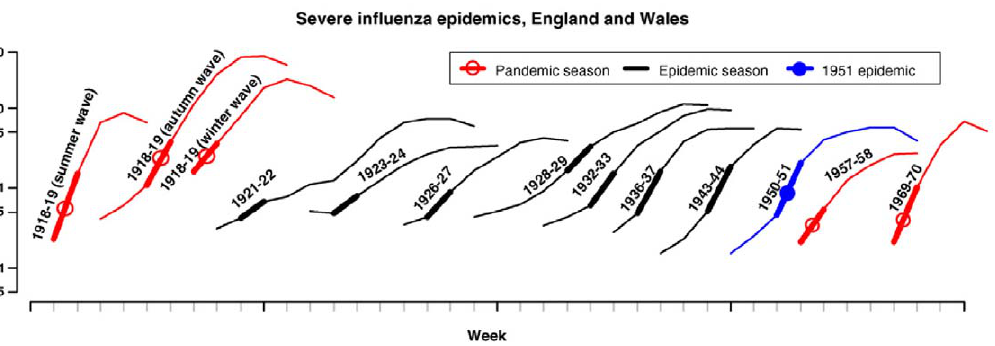
Figure 2. Influenza A (H1N1) weekly mortality rates in large cities in England and Wales for the major influenza outbreaks 1918 to 1951. Note the log scale on the mortality rates. The thick bars on each of the outbreaks proportional to the basic reproduction number of the epidemic. doi:10.1371/journal.pone.0012951.g002 PLoS ONE |